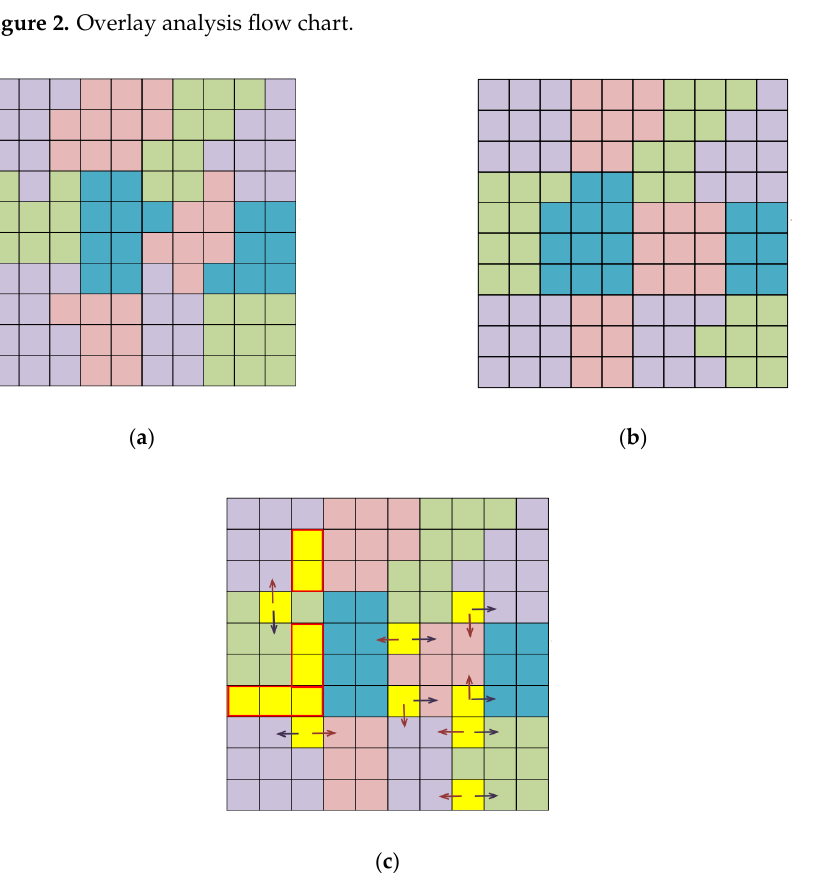
Figure 3. Enlarged overlay analysis illustration: ( a ) T 1 superpixel segmentation; ( b ) T 2 superpixel segmentation; ( c ) merging the interfering pixels.